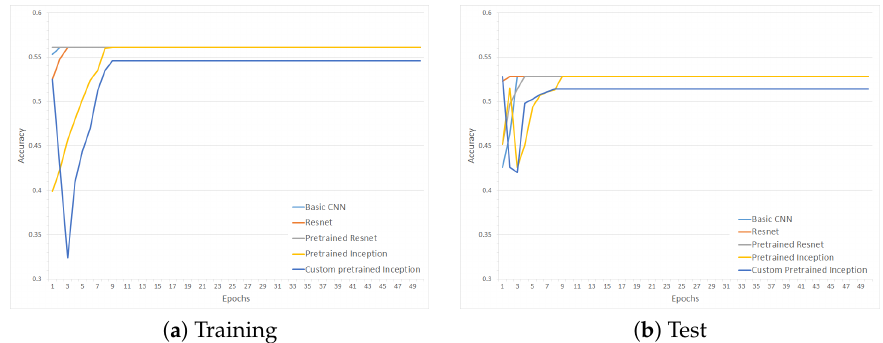
Figure 13. Accuracy of the different architectures on 6-class classification.